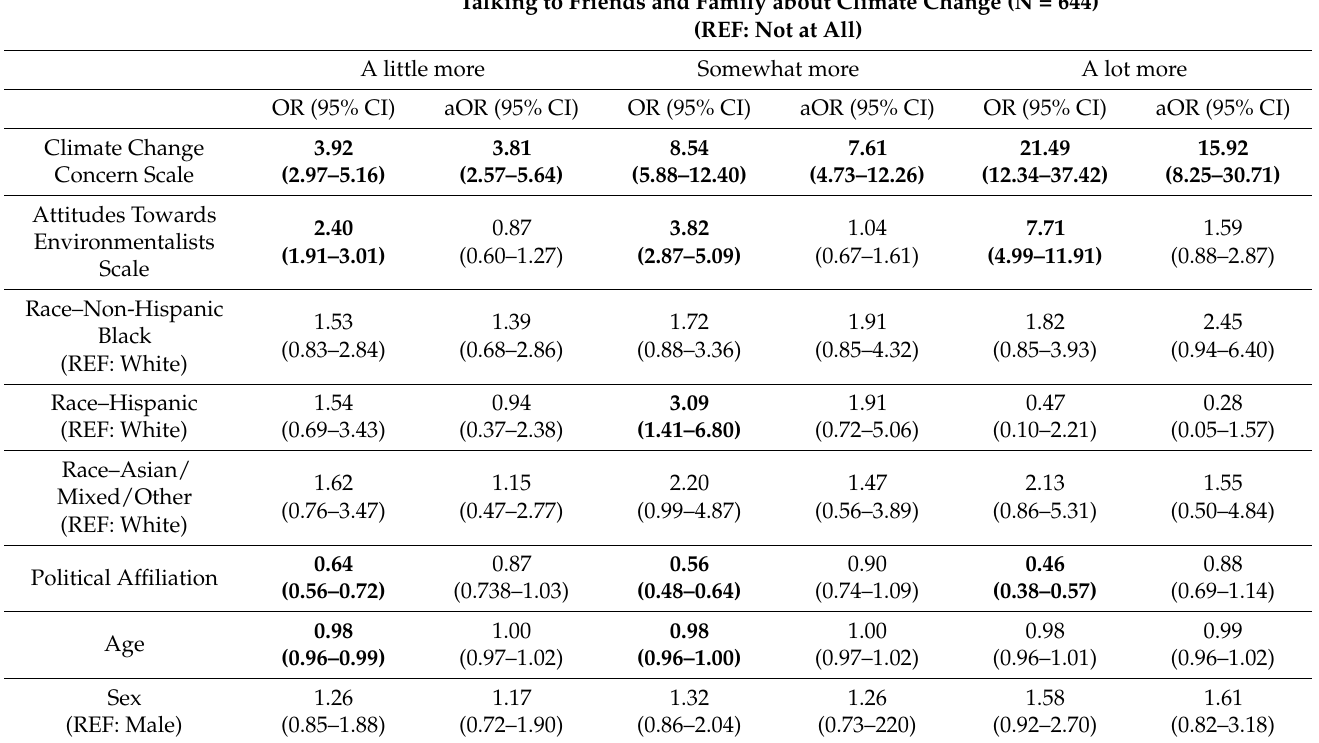
Table 3. Bivariable and multivariable model of willingness to talk to friends and family about climate change, if trained. If Trained, How Much Would You Be Willing to Do the Following Activities? Talking to Friends and Family about Climate Change (N = 644) (REF: Not at